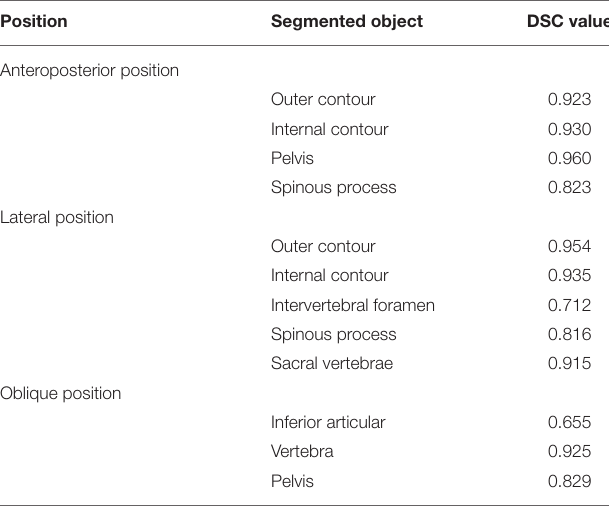
TABLE 2 | The segmentation performance (DSC value) of the scSE U-net model on the anatomy structures of anteroposterior, lateral, oblique position. Position Segmented object DSC value Anteroposterior position Outer